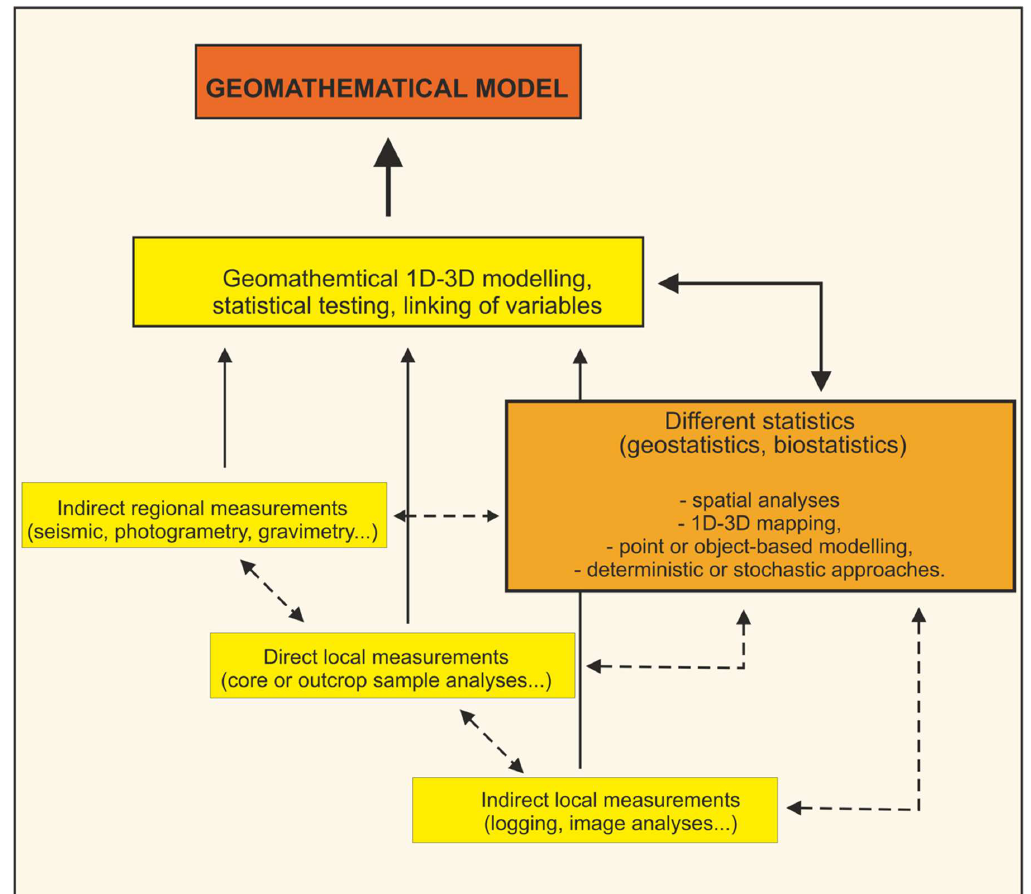
Figure 2. Simple decision tree for geomathematical analysis.